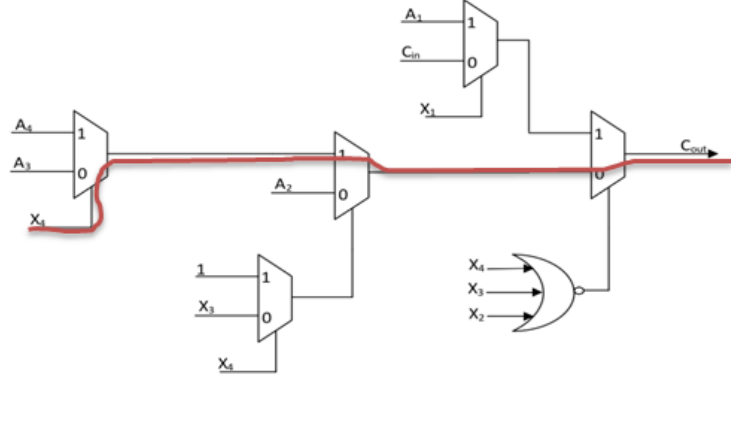
Figure 10. CPD of Figure